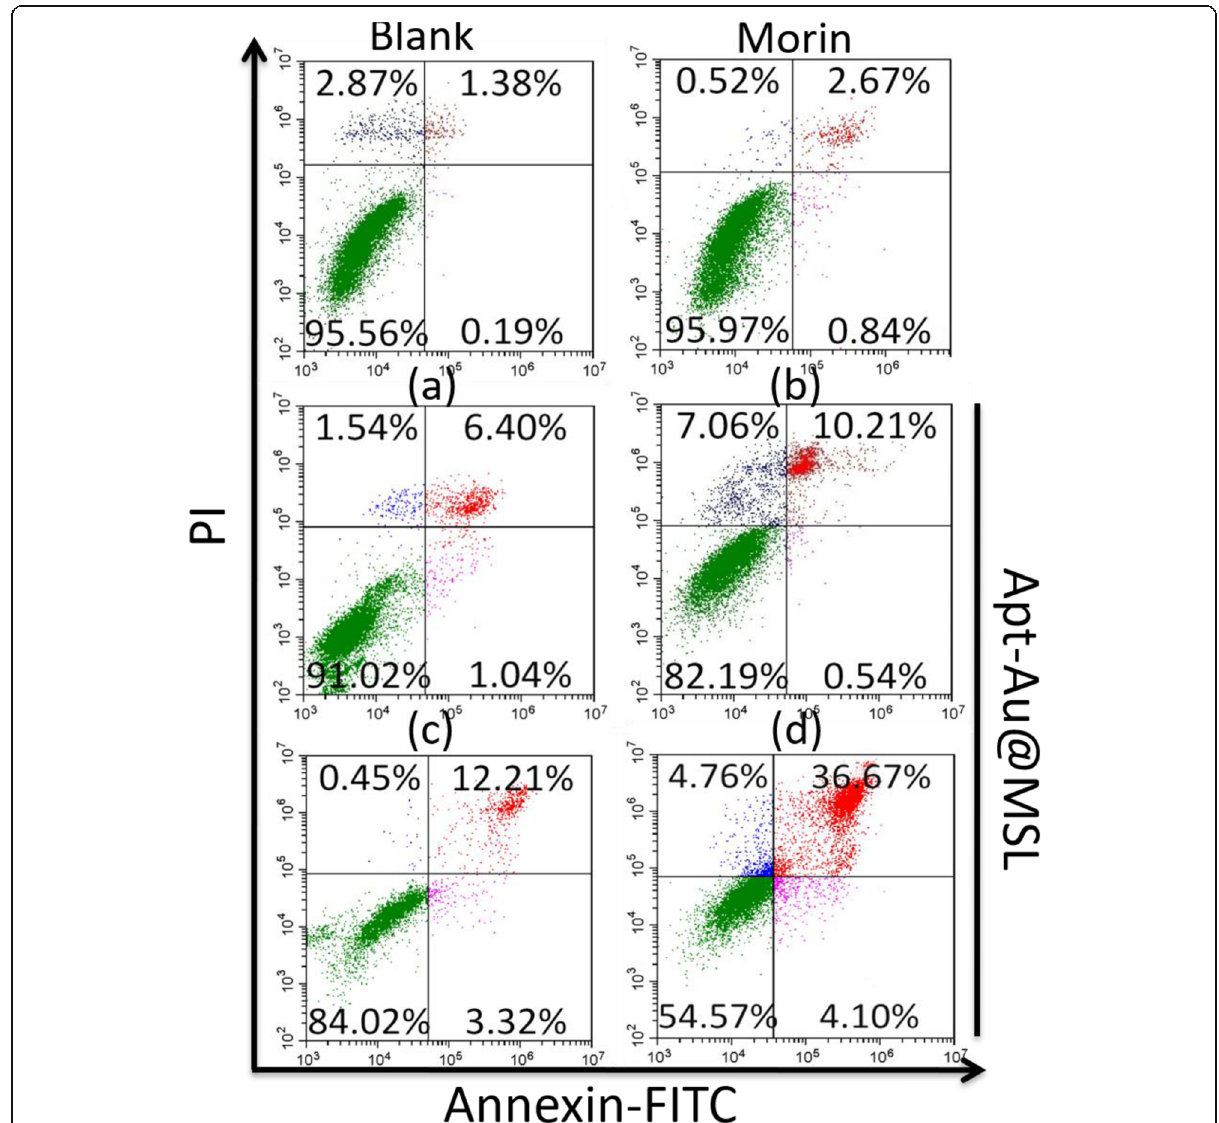
Fig. 5 Annexin V-FITC/PI staining-based flow cytometry analysis of SGC-7901 apoptosis after treating with different methods. The concentration of a , b , c , and d is 5, 10, 20, and 30 μ g/mL,